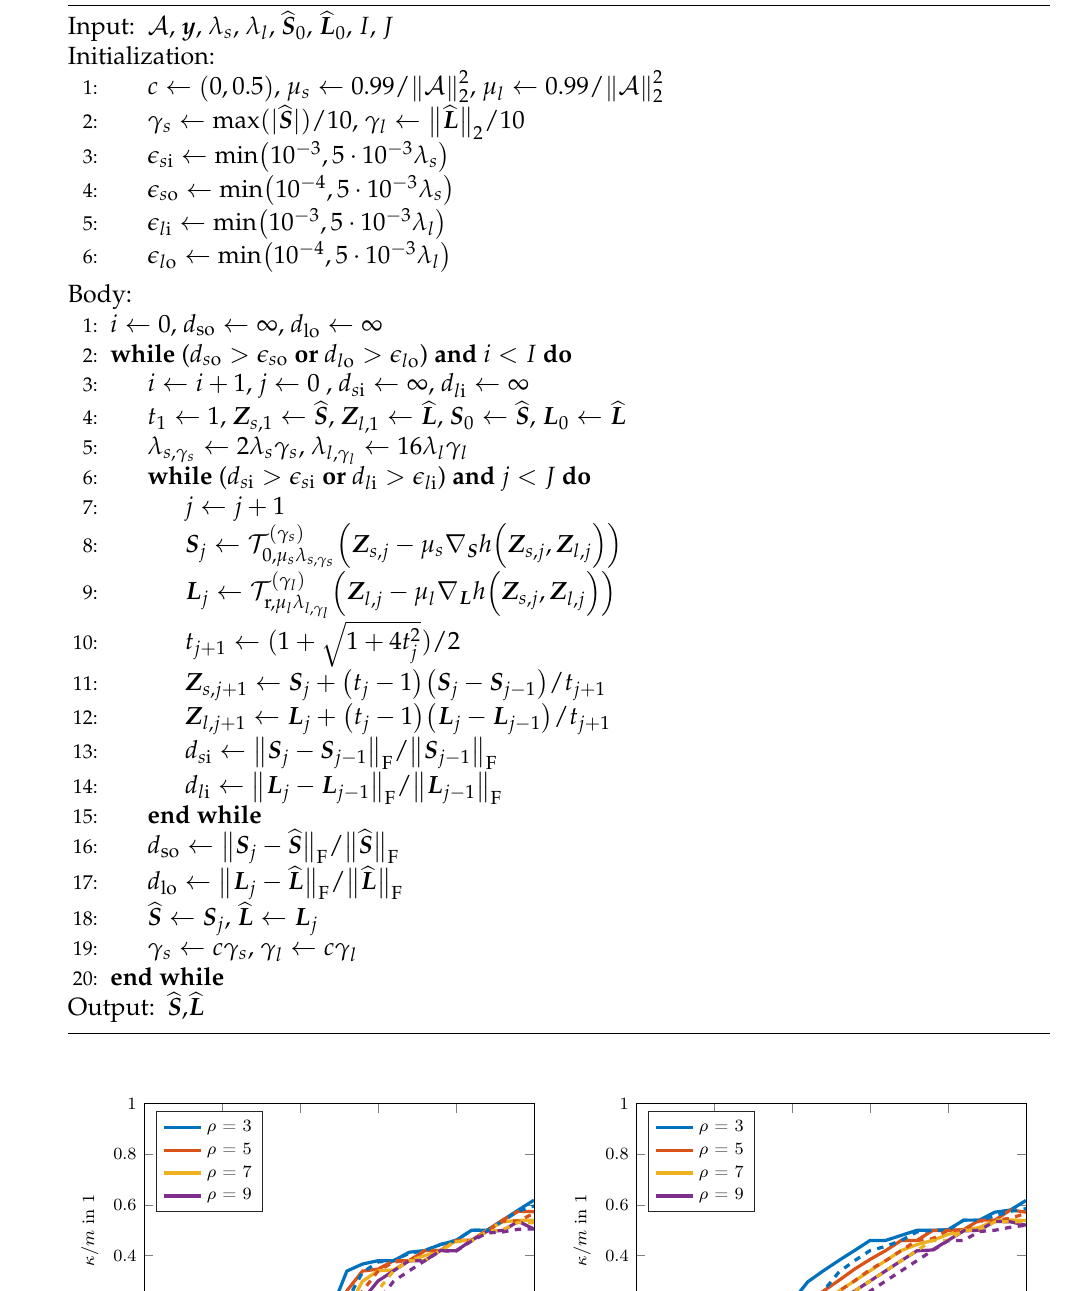
Algorithm 6 Part 2 of TCRPCA algorithm delivering refined solution.